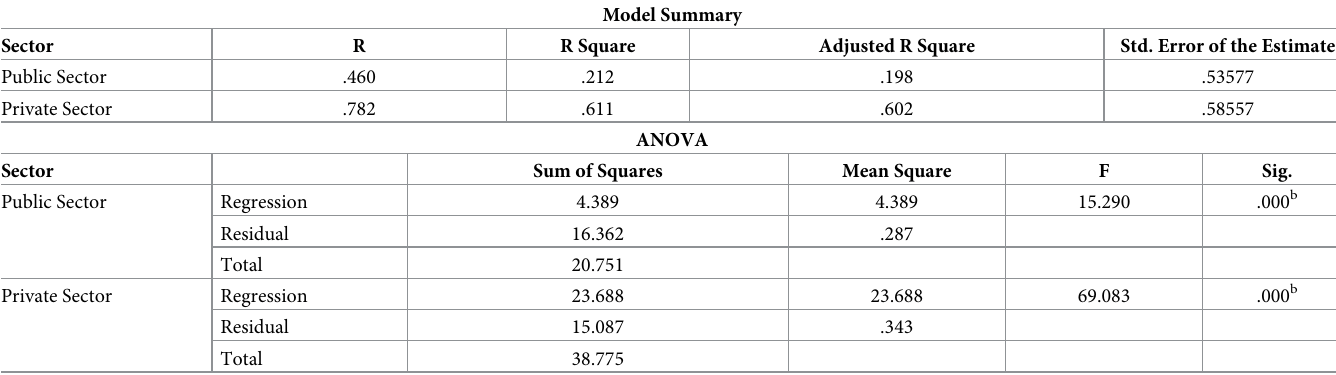
Table 6. Comparative linear regression analysis.